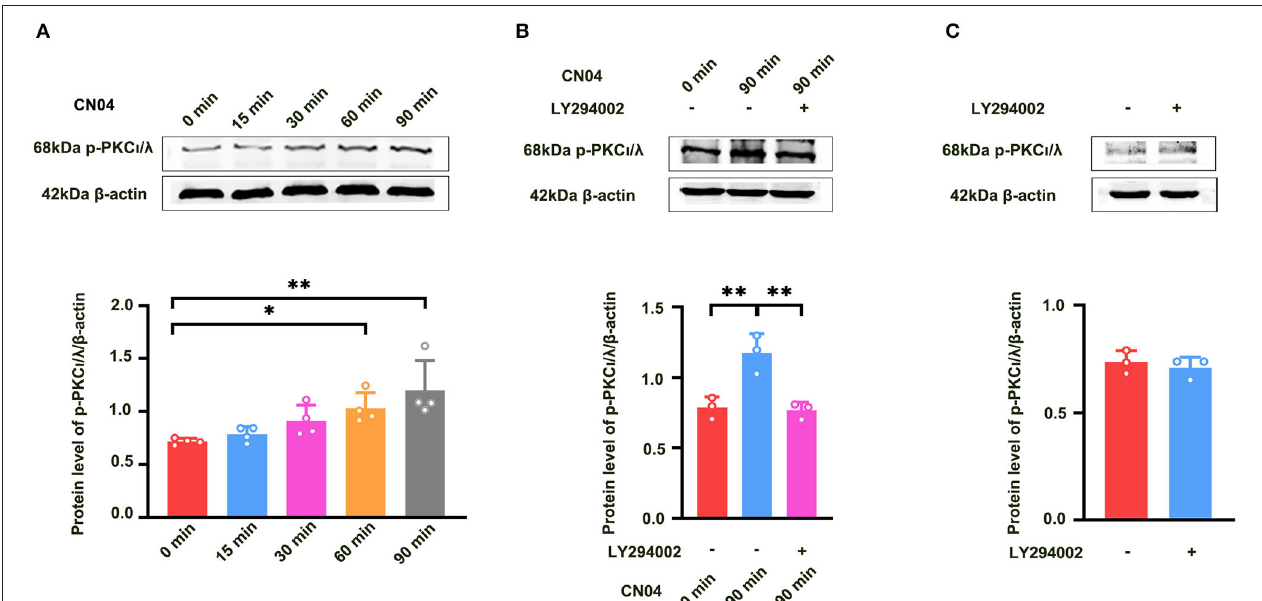
FIGURE 4 | Influence of P13K inhibitor LY294002 on Rac1-induced activation of PKC ι / λ . (A) Influence of Rac1 agonist CN04 (424nM) on PKC ι / λ activation (one-way ANOVA, * P < 0.05, ** P < 0.01, n = 4 in each group). (B) Influence of P13K inhibitor LY294002 (100 µ M) on the effects of Rac1 agonist CN04 (424nM) on PKC ι / λ activation (one-way ANOVA, ** P < 0.01, n = 3 in each group). (C) Influence of P13K inhibitor LY294002 (100 µ M) on PKC ι / λ activation (unpaired t- test, P > 0.05, n = 3 in each group). All data are shown as mean ± SEM.